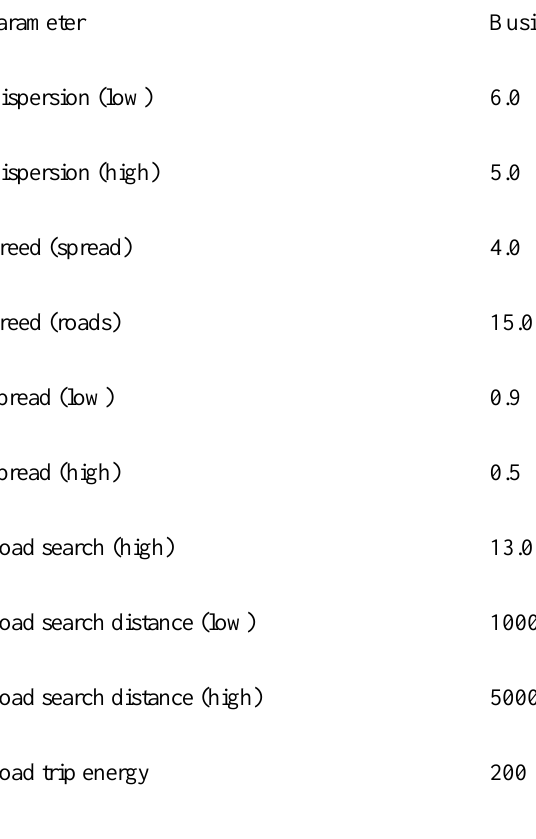
Table B. Urban growth model parameters.